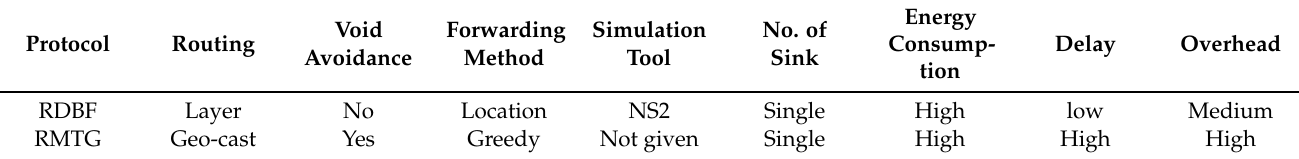
Table 14. Comparison of Sender-Based Routing